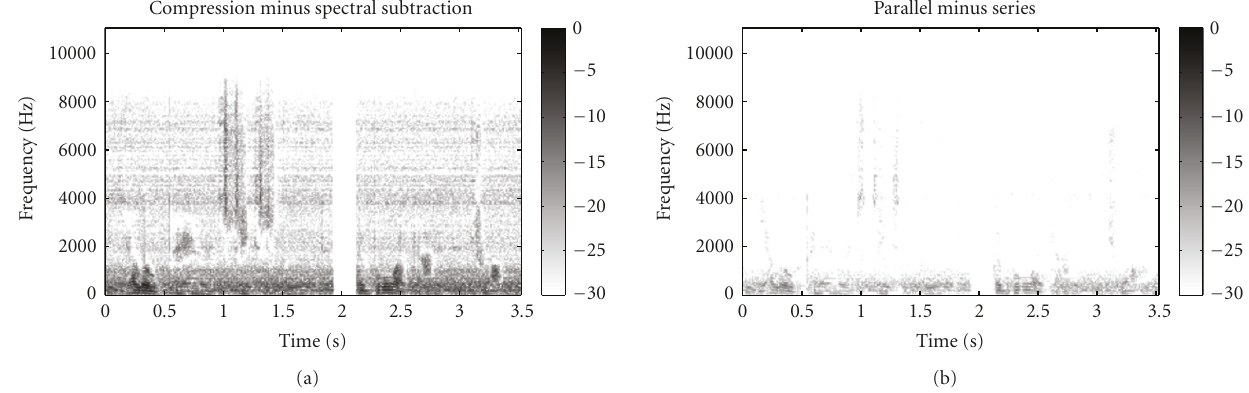
Figure 4: Di ff erence spectrograms: (a) shows compression-spectral subtraction, and (b) shows series-parallel. Spectrograms depict di ff erence in energy between the two contrasted processing conditions. For both (a) and (b), the primary region of di ff erence is in the low frequencies, consistent with the fact that both the speech and noise have a low-frequency concentration. The spectrograms were derived by normalizing the bin with the maximum di ff erence to 0 dB (black shading) and then setting all smaller di ff erences on a gray scale moving to − 30dB from maximum di ff erence (white